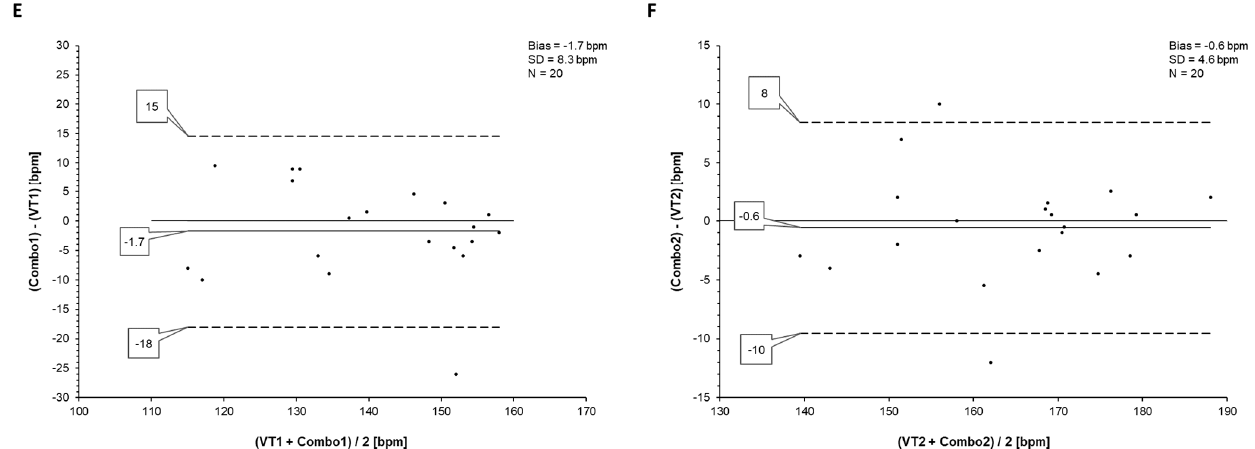
Figure 3. Bland–Altman analysis for VT1 vs. HRVT1 ( A ), VT2 vs. HRVT2 ( B ), VT1 vs. EDRT1 ( C ), VT2 vs. EDRT2 ( D ), VT1 vs. Combo1 ( E ), and VT2 vs. Combo2 ( F ) with bias, standard deviation (SD), and total tests compared (N). Center line in each plot represents the mean difference between each paired value; the top and bottom lines are 1.96 SD from the mean difference.